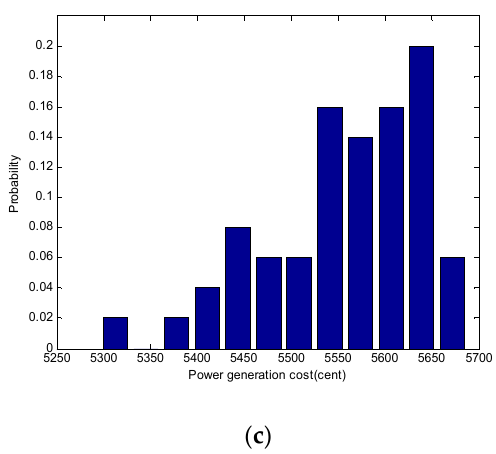
Figure 12. The probability density diagram of the total power generation cost of the three hubs in the multi-energy hub system under different wind speed sequences: ( a ) Energy hub 1; ( b ) energy hub 2; ( c ) energy hub 3.